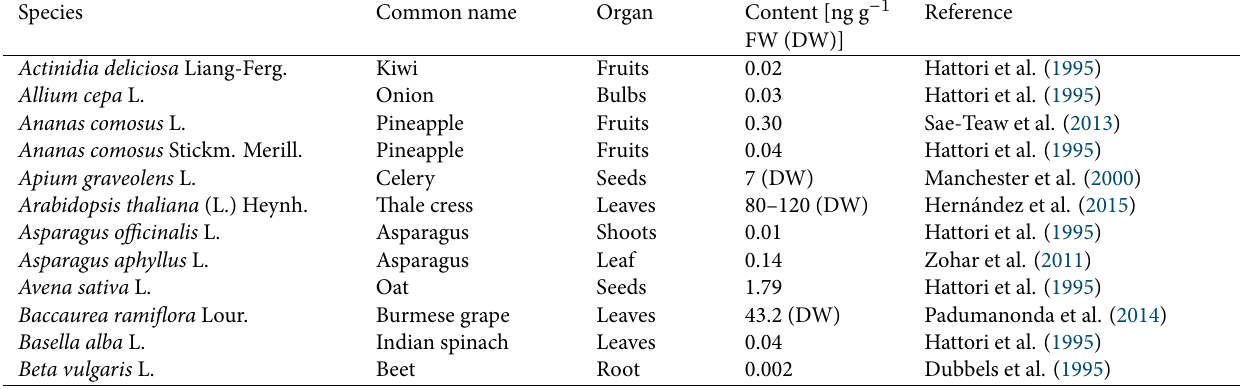
Table 1 Content of melatonin in particular